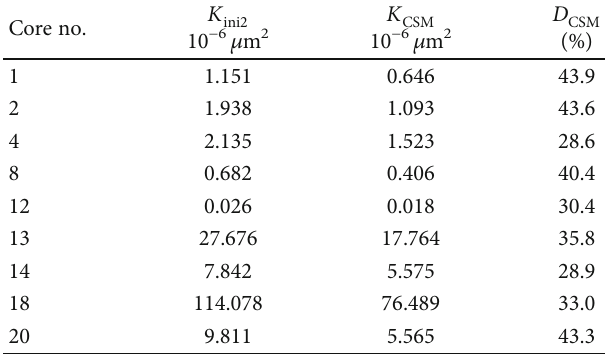
Table 5: CSM damage test results of the tight sandstone